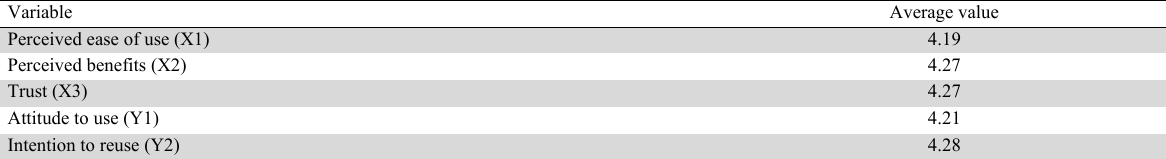
Descriptive Statistical Analysis